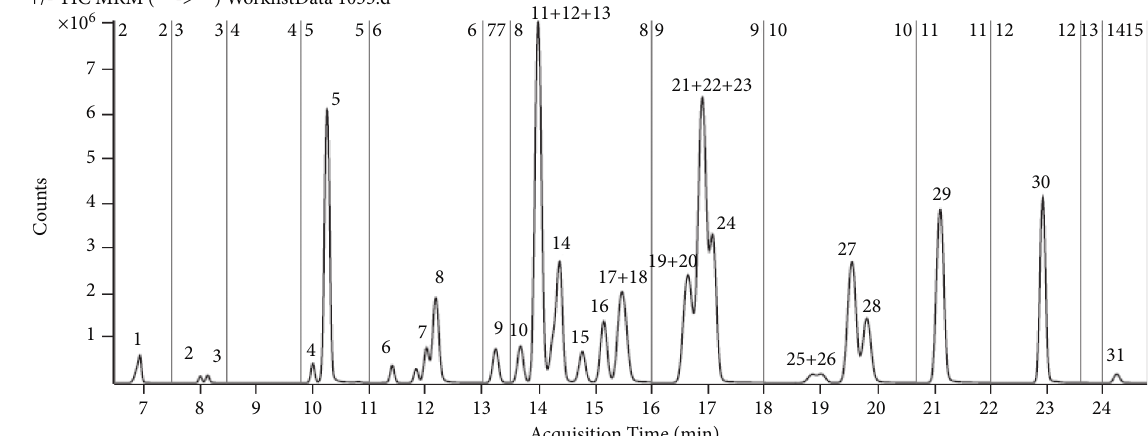
Figure 1: High-performance liquid chromatography multiple reaction mode (HPLC-MRM) chromatogram of 1mg/L of 31 pesticide